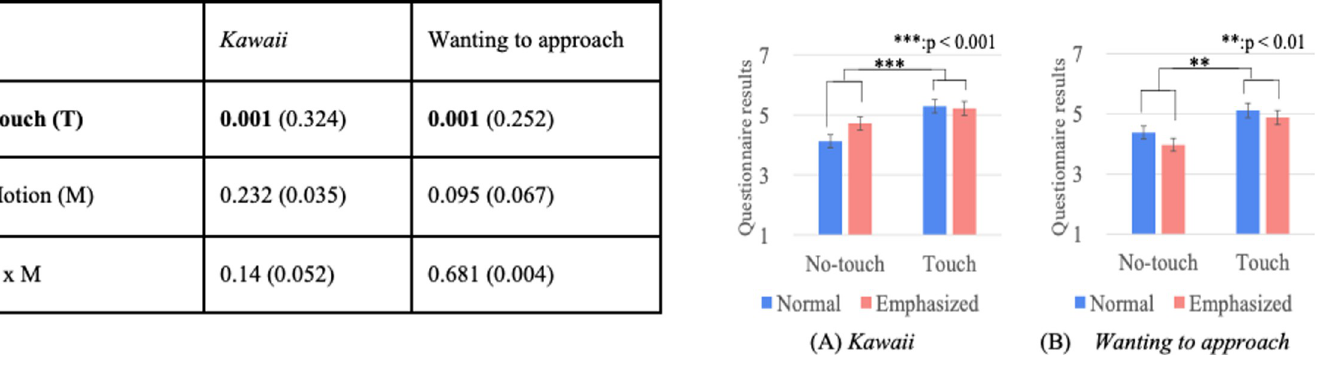
Fig 4. Perceived robot’s feeling of kawaii and wanting to approach